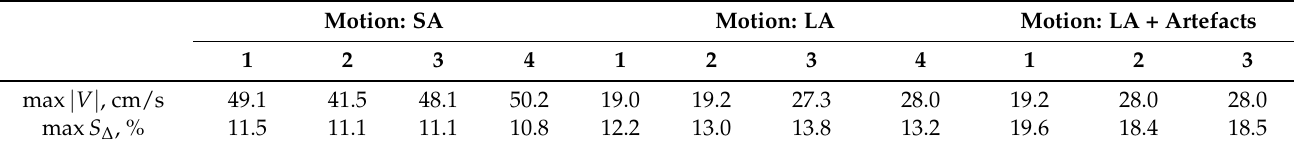
Table 3. Peak S ∆ values (including S + ∆ ) for the local filter at near maximum body velocity for all validation